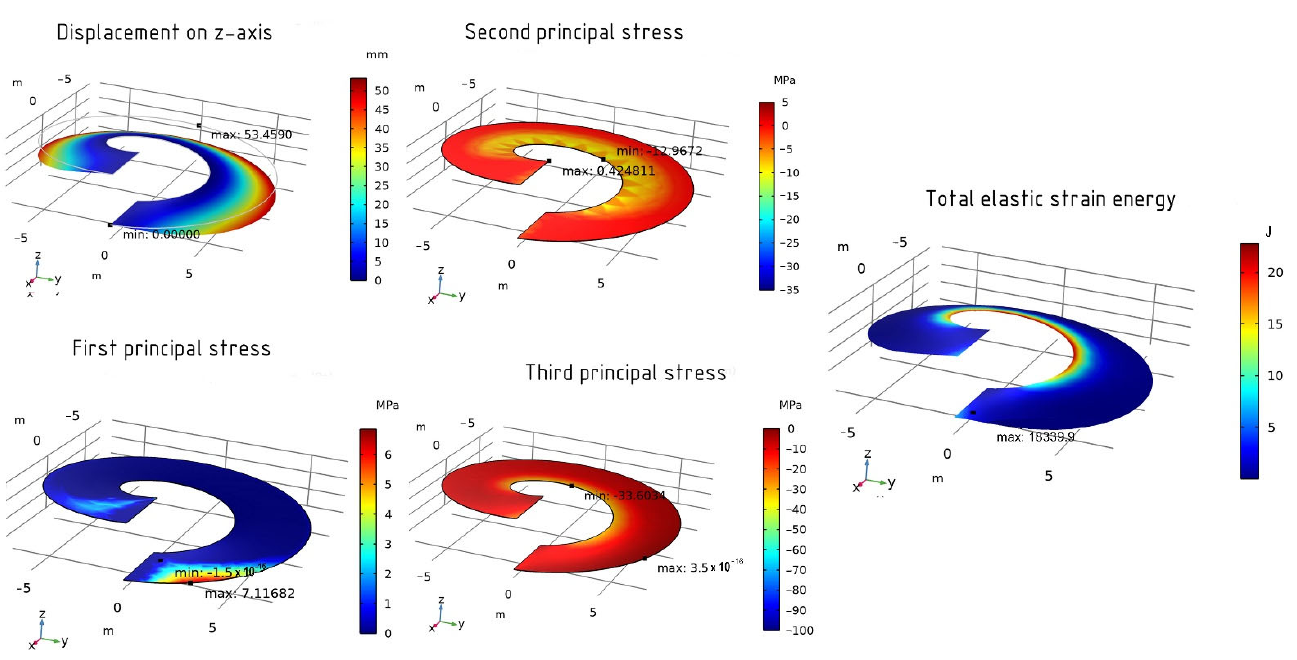
Figure 10. The structural analysis of the helicoid shell (fine element size).